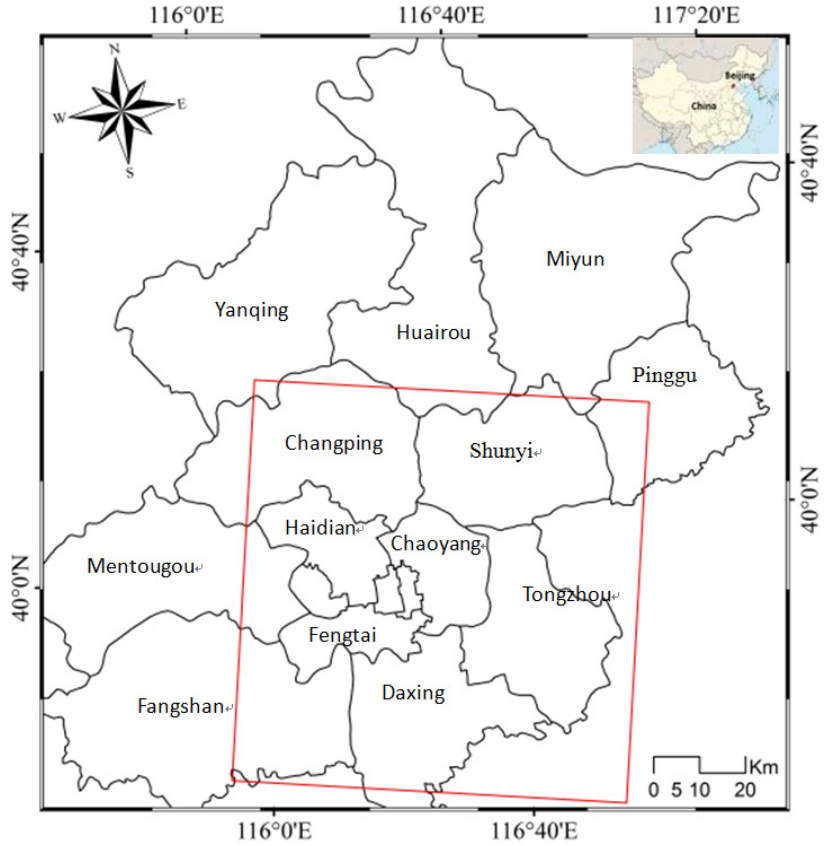
Figure 1. The coverage of the Envisat ASAR datasets used in this study overlaid on Beijing administrative